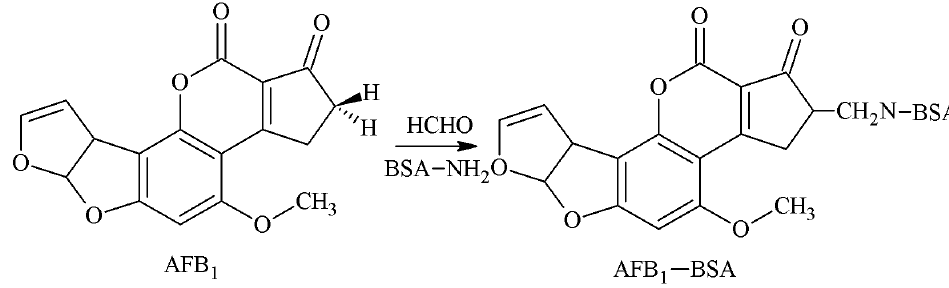
Figure 3. Synthesis of the AFB1-BSA antigen by the methylation of ammonia (MOA) method.